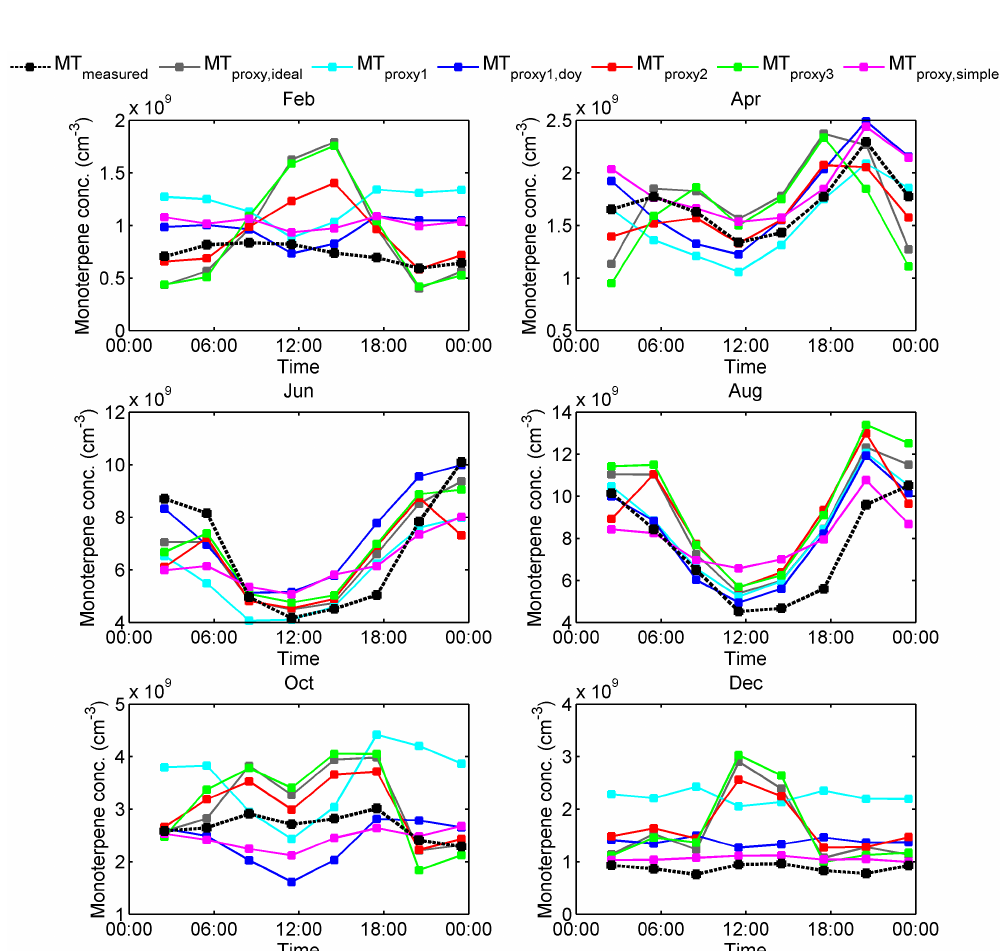
Figure A1. Median diurnal variation of the measured monoterpenes and different proxies in different months (other months are shown in Fig. 7). The black circles show the measured concentration, the gray squares MT proxy , ideal , the light blue squares MT proxy1 , the dark blue squares MT proxy1 , doy , the red squares MT proxy2 , the green squares MT proxy3 and the magenta squares MT proxy , simple .